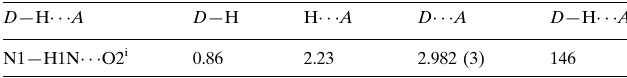
Hydrogen-bond geometry (A˚ , (cid:1)